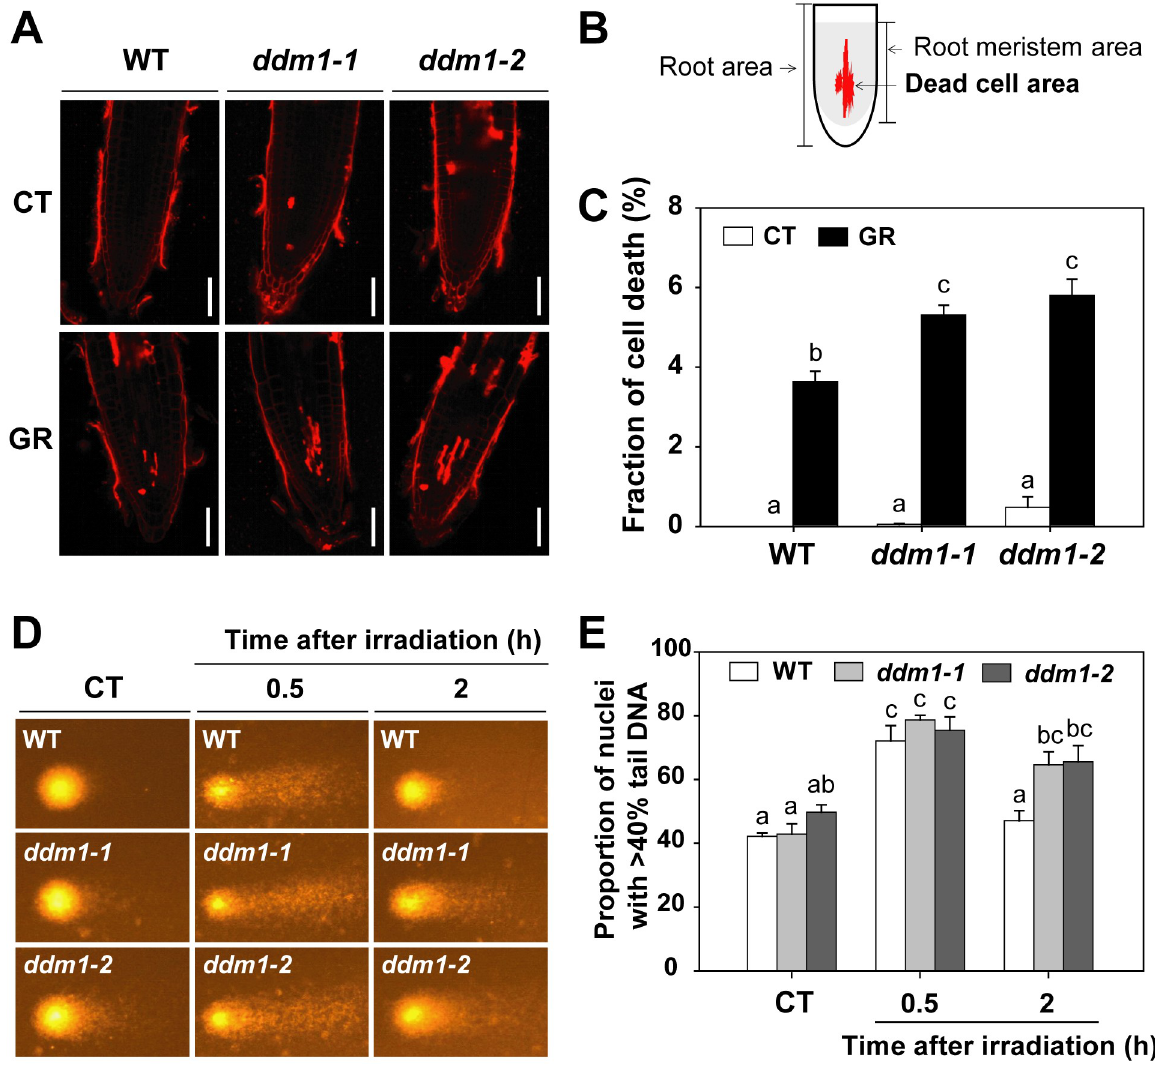
Fig 2. DDM1 mutation increases cellular DNA damage upon exposure to gamma radiation. (A) Representative images of root tips, which were stained with propidium iodide 1 day after gamma irradiation. Scale bars: 50 μ m. (B) Diagram to show extent of dead cell area. (C) Proportion of dead cell area in root meristem. Bars represent means ± SE (n = 19) from three independent experiments. (D) Representative comet images of nuclei and (E) proportion of nuclei with more than 40% tail DNA in WT and ddm1 mutants without or with exposure to 200 Gy of gamma radiation. Bars represent means ± SE (n = 3) of three independent experiments using 250 nuclei. Different letters in (C) and (E) indicate significant differences among the samples at a threshold of P < 0.05 [one-way ANOVA, Tukey’s honestly significant difference (HSD) test]. CT, control; GR, gamma